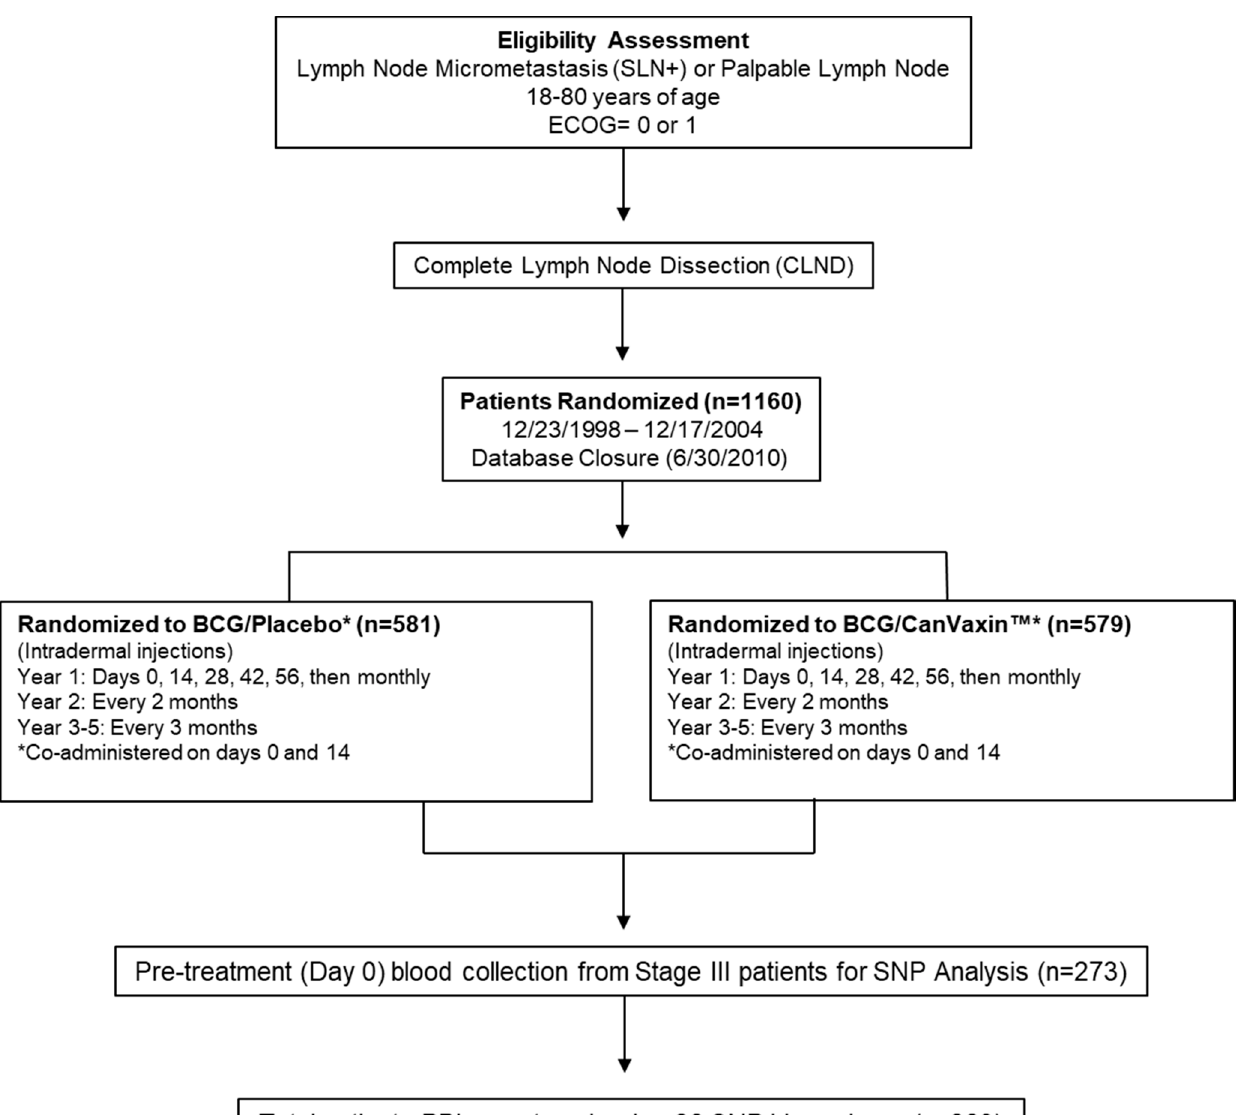
Figure 2. CONSORT diagram of MMAIT-Stage III patients from the phase III randomized double-blinded international multi-center trial. The flow diagram describing the MMAIT-III (NCT00052130) trial is shown. Selected 269 patients from MMAIT-III trial were used as a verification cohort. ECOG = Eastern Cooperative Oncology Group; MMAIT = Malignant Melanoma Active Immunotherapy Trial; SLN = Sentinel Lymph Node; PBL = Peripheral Blood Leukocytes; SNP = Single Nucleotide Polymorphism.